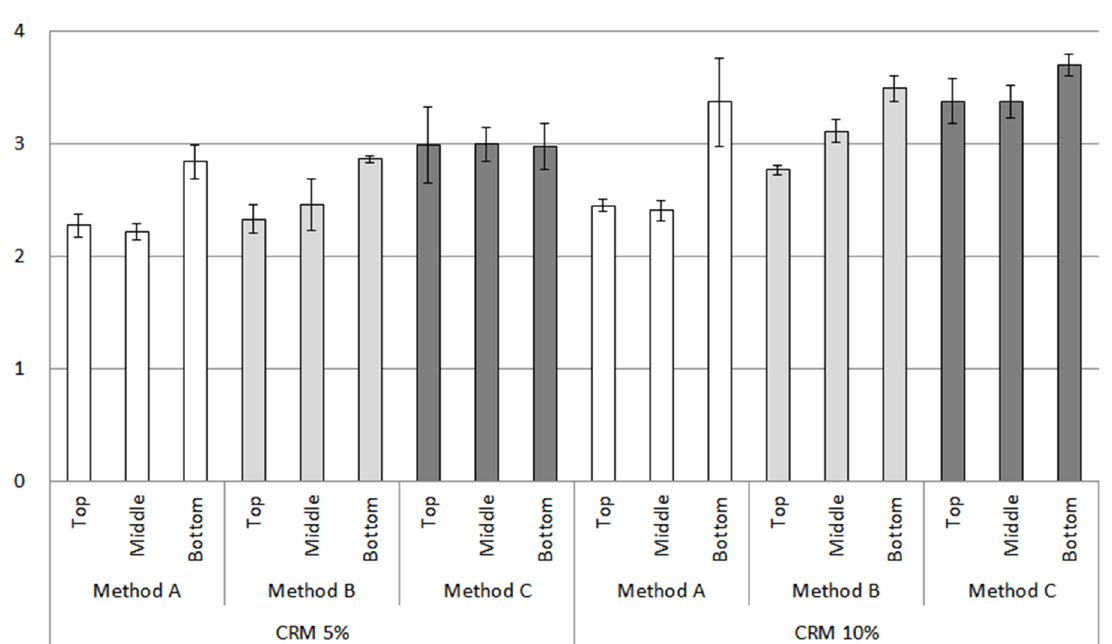
Figure 11. G*/sin δ of the CRM asphalt binders for each mixing method for the top, middle, and bottom parts after conditioning. bottom parts after